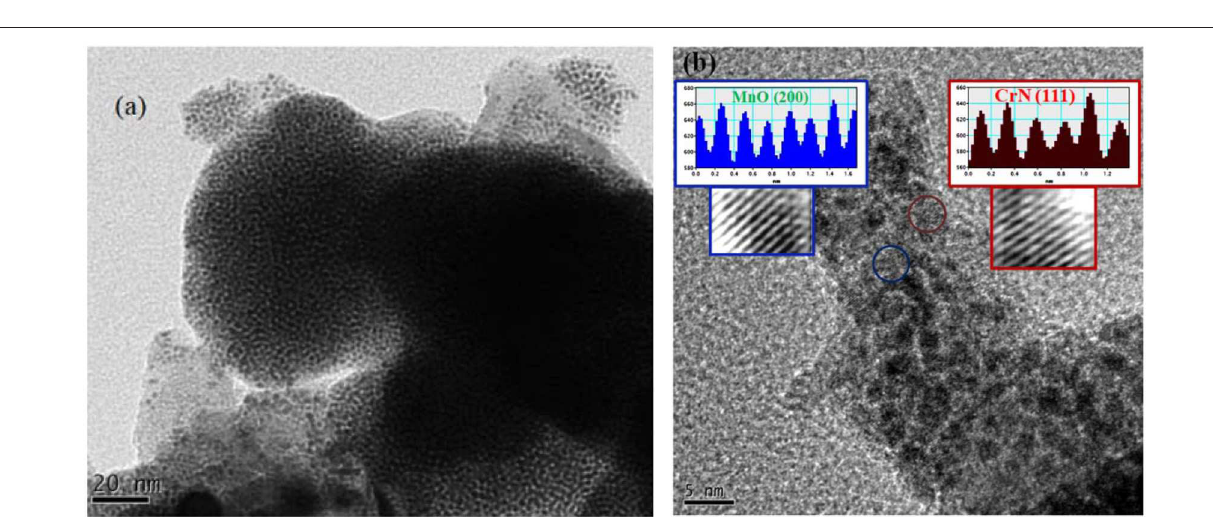
FIGURE 5 | SEM image and EDX mapping of Cr/rGO nanocomposite with MnO, synthesized at 900 ◦ C in 9h. SEM, scanning electron microscopy; EDX, energy-dispersive X-ray.